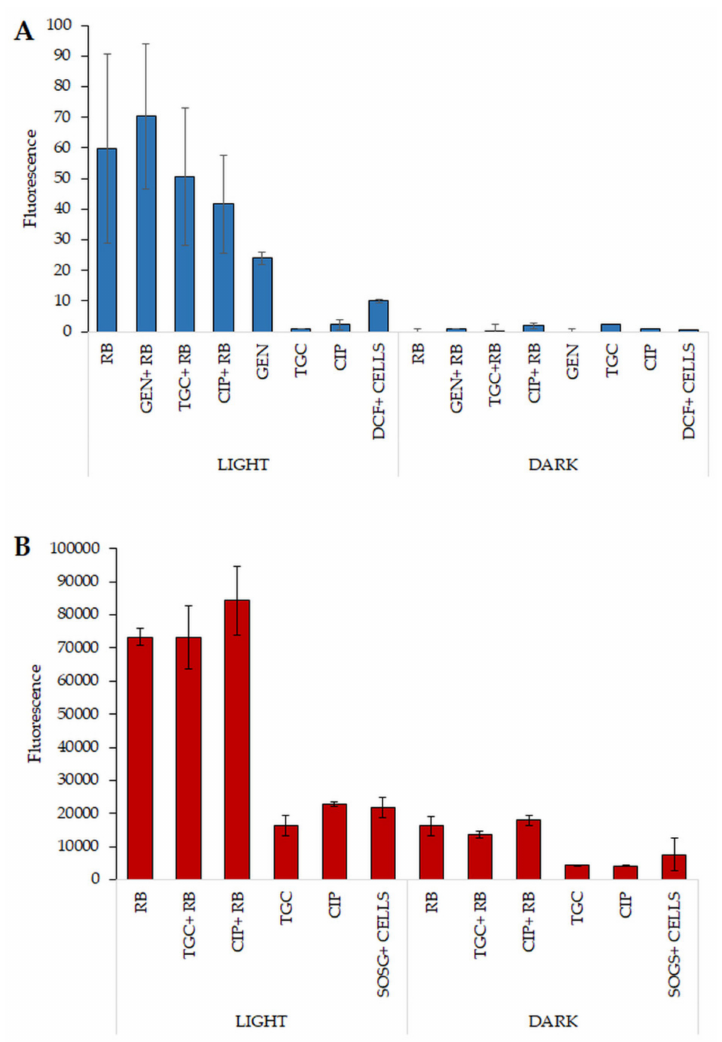
Figure 6. Reactive oxygen species and singlet oxygen identification. ( A ) Exposure of E. faecalis to various oxidative stress conditions and antibiotic monotherapies at MIC concentrations. For experimental purposes, dark controls of the tested combinations were also analyzed. The fluorescence of DCF was observed using wavelengths of 521 nm (emission) and 488 nm (excitation) with an EnVision multilabel plate reader (PerkinElmer, Waltham, MA, USA). The values are the mean of three independent experiments. ( B ) Cell suspensions of E. faecalis were exposed to mono- and combination therapies to detect singlet oxygen production. Fluorescence was measured at excitation/emission wavelengths of 505/523 nm with an EnVision multilabel plate reader